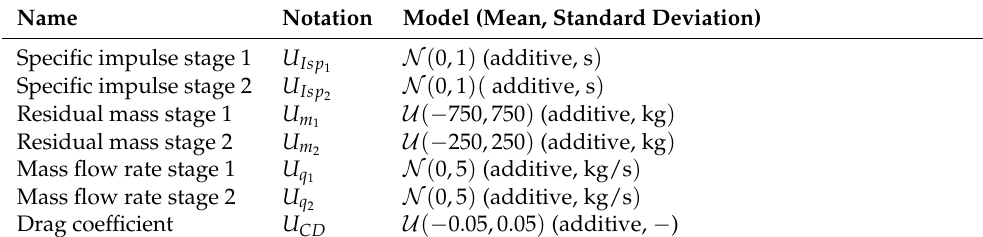
Table 2. Probability distribution of the input uncertain random vector.